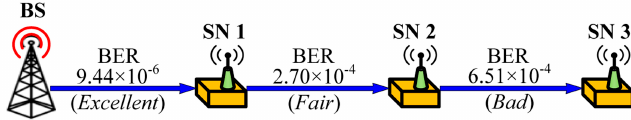
Figure 9. Configuration for the performance evaluation.